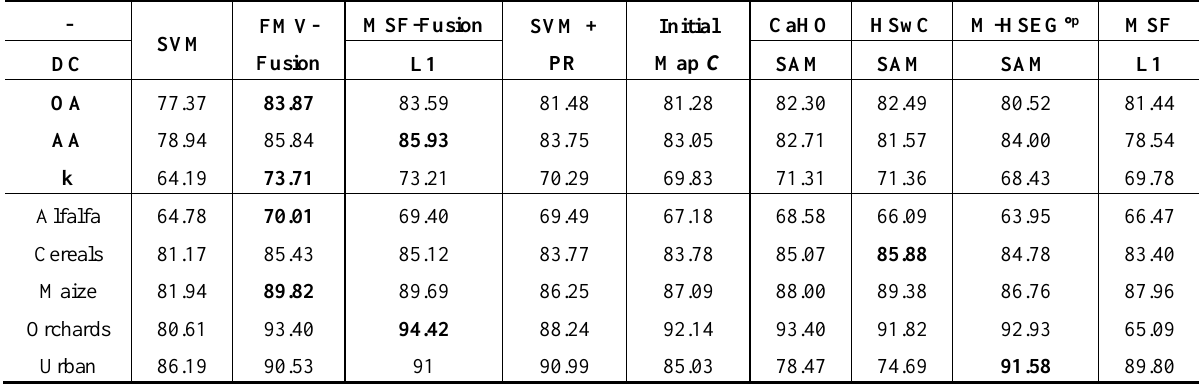
Table 5. Classification accuracies for the Koronia